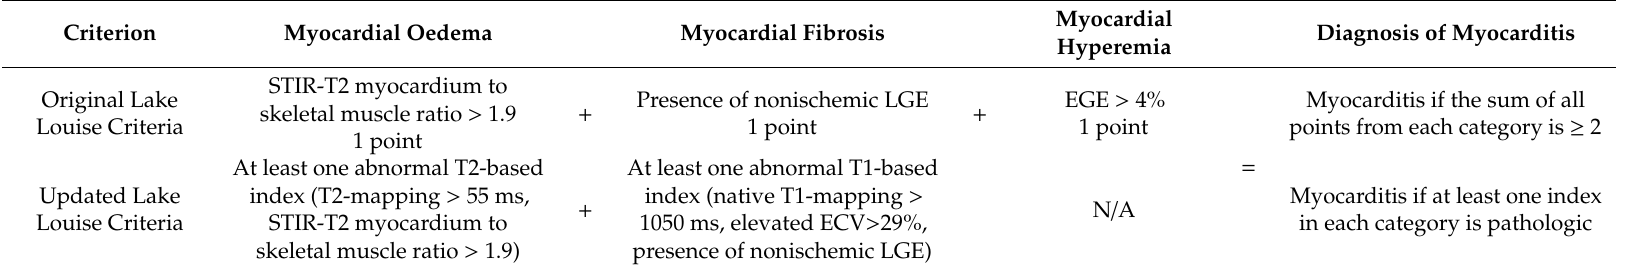
Table 1. Definition of myocarditis / myocardial inflammation based on the original and updated Lake Louise criteria. The original criteria evaluate a single variable for each of the domains of myocardial oedema, fibrosis and hyperemia. The updated criteria do not take myocardial hyperemia into account and instead only make use of one pathological T1-based index and one pathological T2-based index for the domains of myocardial fibrosis and oedema